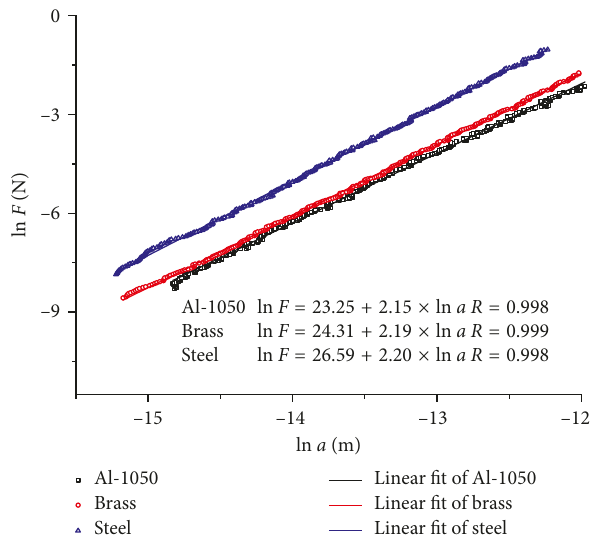
Figure 4: Linear regression of ln( F ) versus ln( a ) for the experi- mental